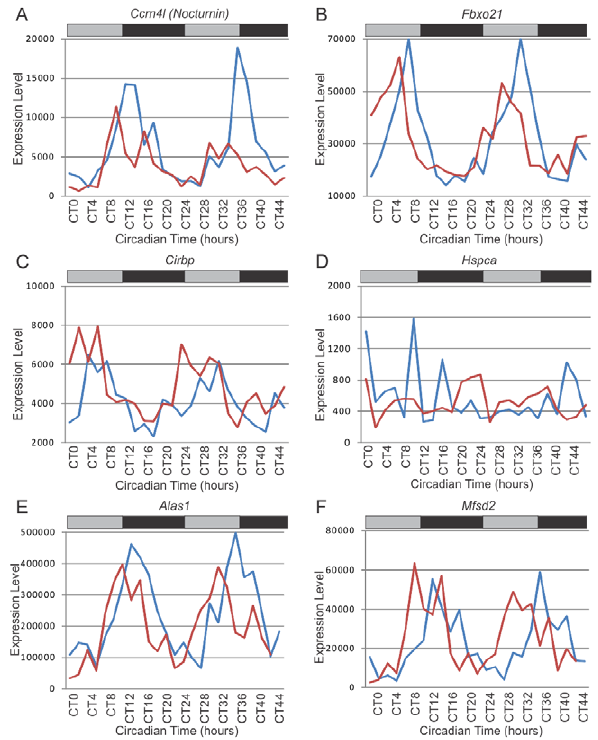
Figure 5. Examples of System-driven circadian transcripts. Microarray expression levels in wildtype (blue) and Clock -rescue (red) animals for six notable system-driven genes, including Nocturnin (A), Fbxo21 (B), Cirbp (C), Hspca (D), Alas1 (E), and Mfsd2 (F). Grey and black bars represent subjective day and night, respectively.